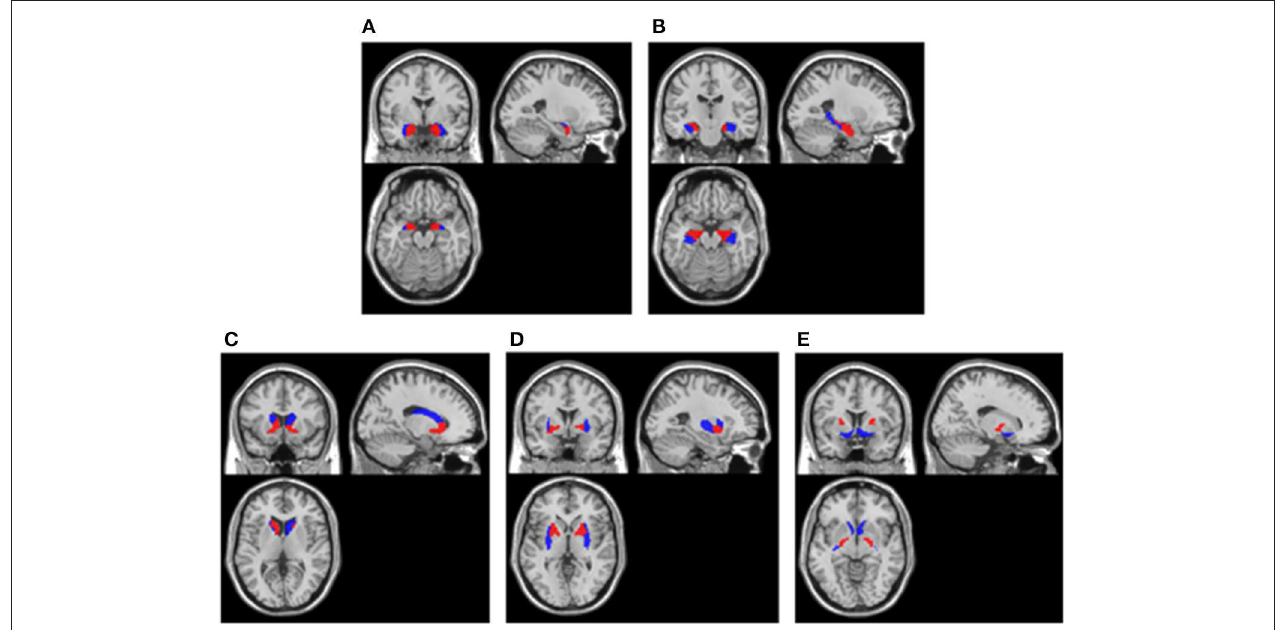
FIGURE 1 | ROIs extracted in cerebral cortex. (A) Amygdala. Blue areas were lateral amygdala and red areas were medial amygdala; (B) Hippocampus. Blue areas were caudal hippocampus and red areas were rostral hippocampus; (C) Caudate nucleus. Blue areas were dorsolateral caudate nucleus and red areas were ventral caudate nucleus; (D) Putamen. Blue areas were dorsolateral putamen and red areas were ventromedial putamen; (E) Pallidum and Nucleus accumbens. Blue areas were nucleus accumbens and red areas were pallidum. All ROIs were extracted using the Human Brainnetome Atlas (21) and they were overlay on a MNI single subject T1 scan